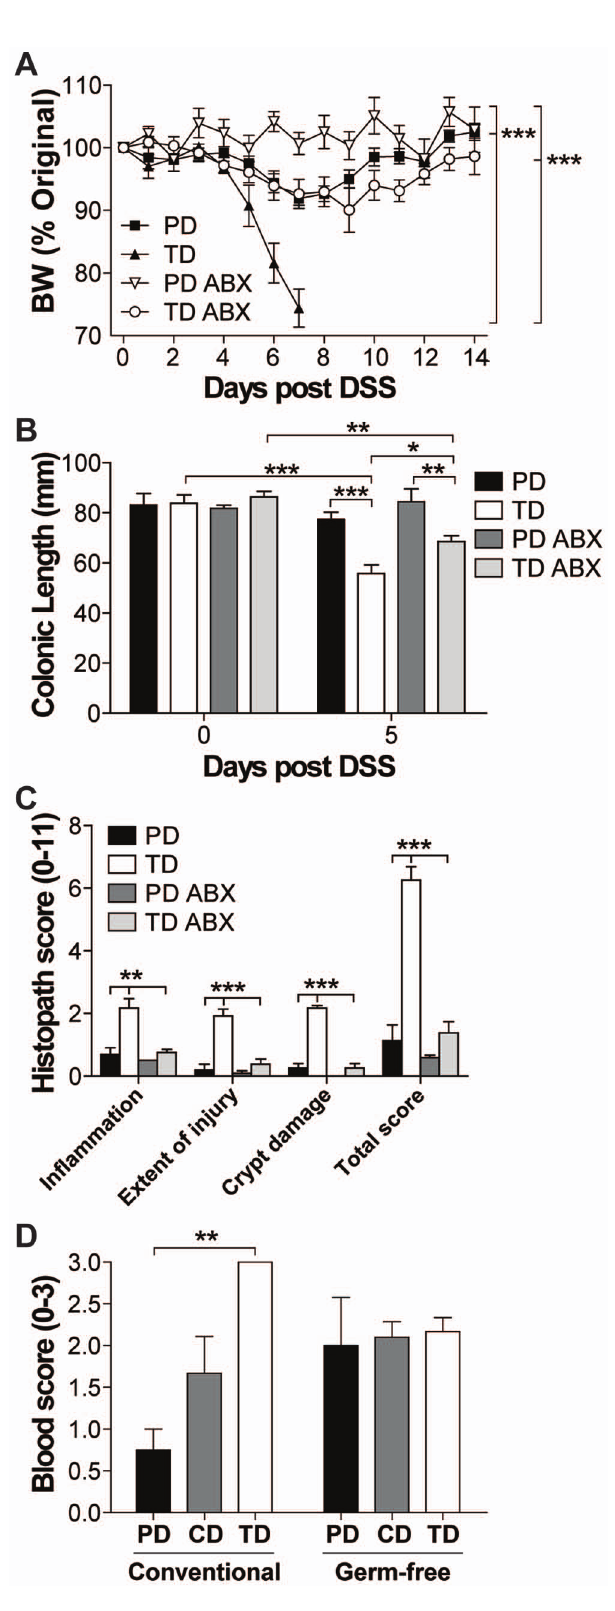
Figure 4. ABX treatments protected PD- and TD-fed mice from DSS-induced colitis. WT mice were treated continuously with ABX and fed PD or TD for 2 wks prior to 2.5% DSS treatment. (A) Percent original BW of ABX treated PD- or TD-fed mice following the start of DSS treatment (n=3–4 mice/group). Significant difference in BW